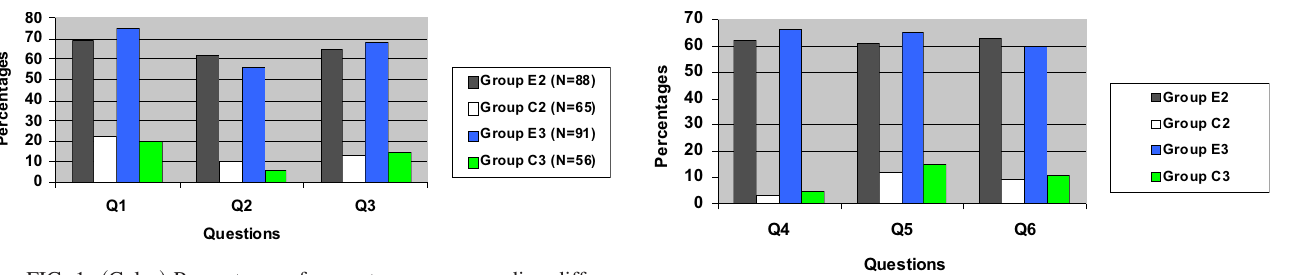
FIG. 1. (cid:1) Color (cid:2) Percentages of correct answers regarding differ- entiation between charge and potential. FIG. 2. (cid:1) Color (cid:2) Percentages of correct answers on the meaning